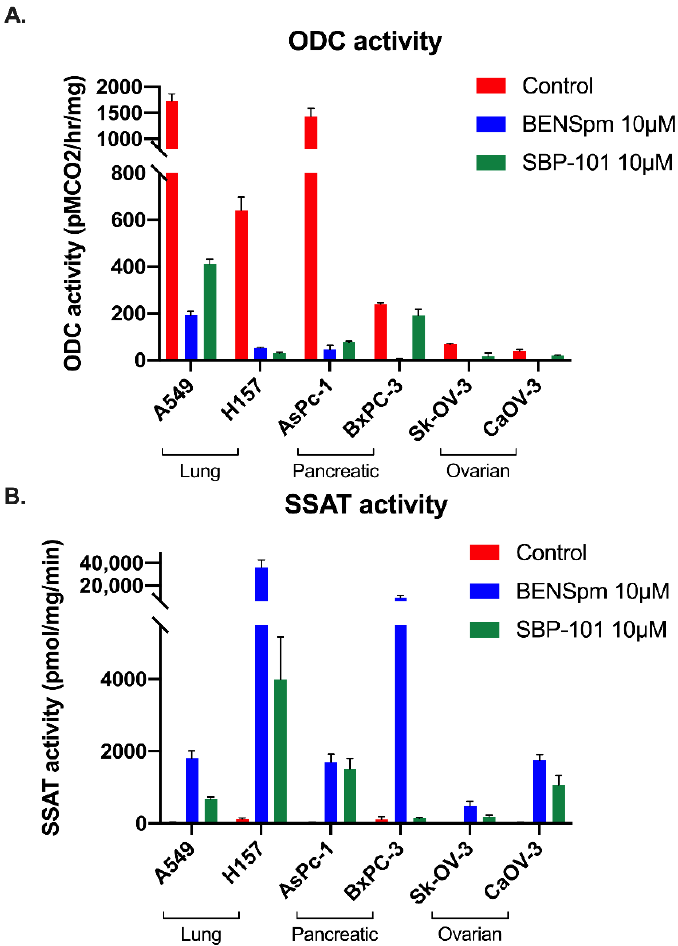
Figure 4. Polyamine metabolism is influenced by SBP-101 treatment through ODC inhibition and modest SSAT upregulation. Following treatment with 10 μ M of BENSpm or SBP-101 for 24 h, lung, pancreatic, and ovarian adenocarcinoma cells were collected, and lysates were tested for ODC and SSAT enzyme activity. Both BENSpm and SBP-101 substantially reduced the activity of the bi- osynthetic enzyme ODC ( A ). BENSpm treatment resulted in the induction of the catabolic enzyme SSAT in all treated cell lines. SBP-101 also upregulated SSAT activity, albeit to lower levels than BENSpm treatment ( B ). 2.4. SBP-101 Treatment Prolongs Survival and Reduces Tumor Burden in the VDID8 + Ovarian Murine Model Following an I.P. implantation with VEGF- β -Defensin ID8 (VDID8 + ) syngeneic mouse ovarian surface epithelial cells, C57BL/6 mice were treated with 24 mg/kg SBP-101 three times per week on alternating weeks. Due to the weight loss observed in this high- dose group, the treatment with SBP-101 was discontinued after three cycles (five weeks) (Supplemental Figure S1A). These mice continued to be followed for weight change and survival, and ascites and tumor samples were processed for further analysis. An addi- tional experiment was then completed using either a lower dose of 6 mg/kg, 3× per week on alternating weeks or 24 mg/kg once per week on alternating weeks. Neither dose on this schedule showed any weight-related toxicities (Supplemental Figure S1B). Both doses of SBP-101 prolonged the survival of the mice when given 3× per week, with the original high dose (24 mg/kg) yielding a 65-day median survival and the low dose (6 mg/kg) giving